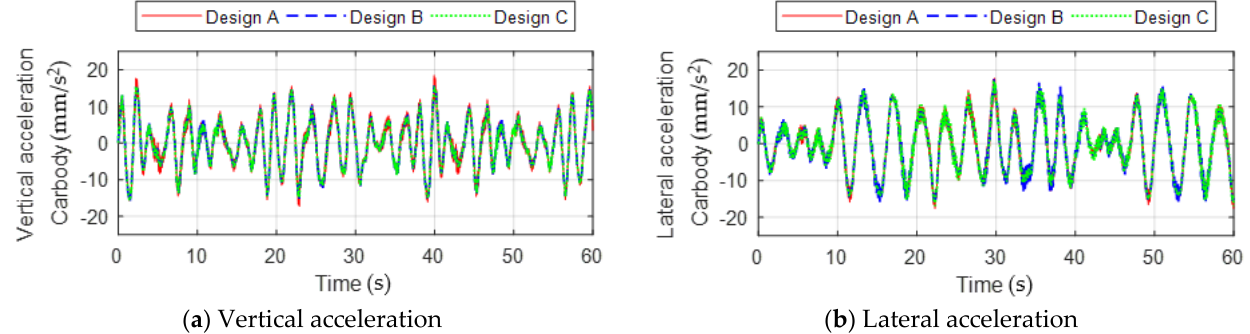
Figure 22. Vertical and lateral accelerations of a carbody at a speed of 300 km/h.